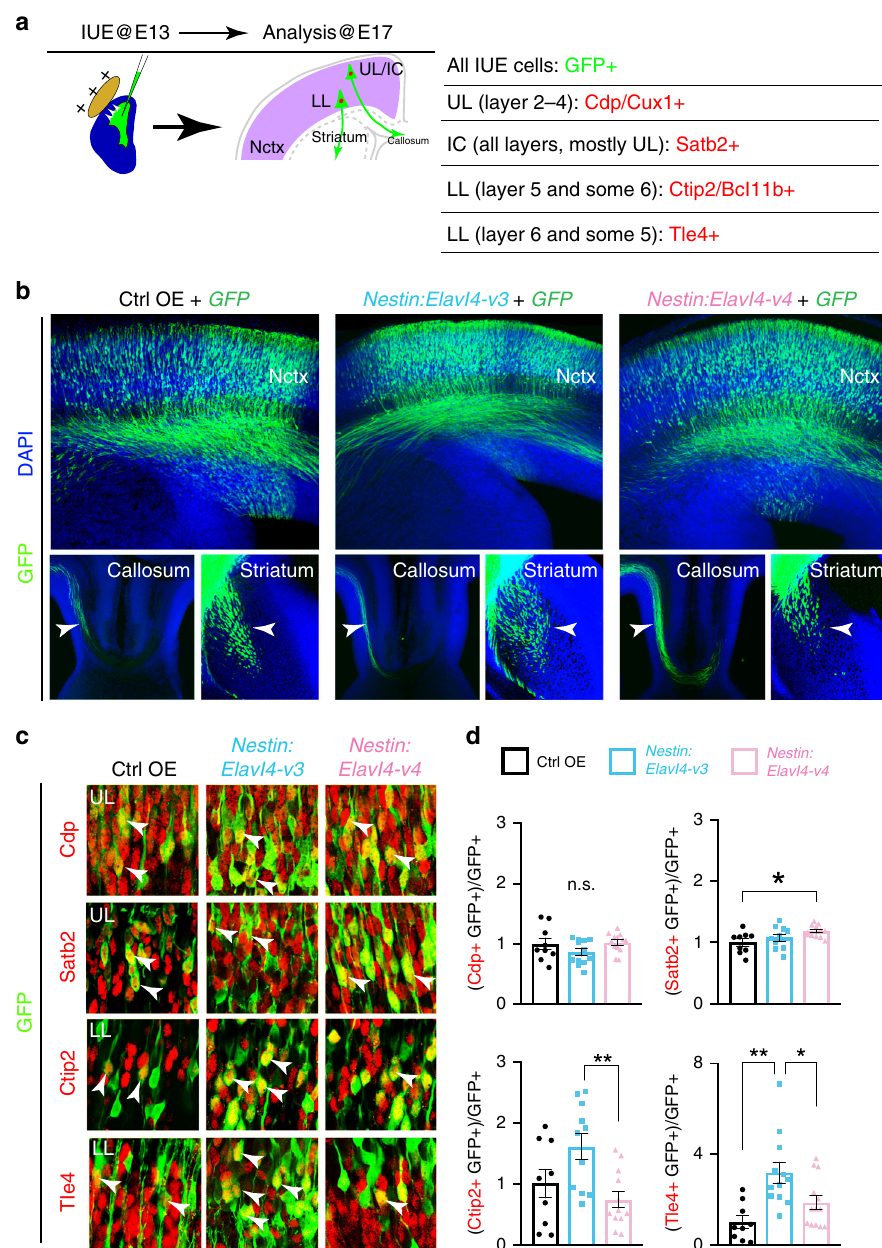
Fig. 6 Elavl4-v3 OE lacking its 5 ′ UTR in neural stem cells promotes LL identity. a Schematic: Neocortical IUE at E13 (left) with CAG-GFP and either Ctrl or Elavl4 constructs were analyzed at E17 for colocalization between GFP and neocortical layer markers as indicated in the chart on the right. Nctx = neocortex, UL = upper layers, LL = lower layers, IC = intracortically projecting. b Representative mages of E17 IUE Nctx, corpus callosum, and striatum. GFP + axons (green) are indicated by arrowheads. Scale bar: 200 μ m. c Representative images of immunostained E17 IUE Nctx electroporated with GFP and either Ctrl ( n = 3 animals), Nestin:Elavl4-v3 ( n = 4 animals), or Nestin:Elavl4-v4 ( n = 4 animals) OE. IHC for GFP (green) and cortical neuron identity markers (red) listed in a . Scale bar: 20 μ m. d Quanti fi cation of colocalization between layer markers and GFP, normalized to Ctrl. Data represent the mean of sections and SEM. Statistics: one-way ANOVA with Tukey ’ s. * p < 0.05, ** p < 0.01, *** p <